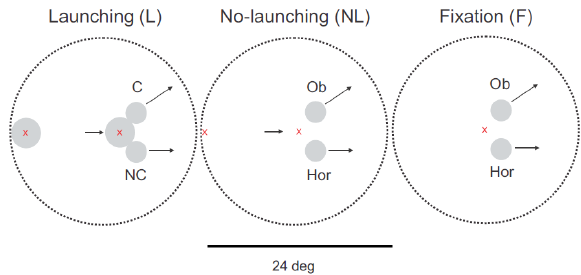
Figure.1 Experimental stimuli. Launching condition: the launcher (‘L’, a round shape of 3 deg size) moved hori- zontally towards the center at a constant velocity of 16 deg/s. The moment L made contact with both targets, its motion stopped and targets started to move (moment of collision/target motion onset; after 1second of visible launcher motion onset). No launching (‘NL’): in this con- dition, only a small fixation cross moved at the same ve- locity than L before targets started to move. Stationary fixation (‘F’): in this condition targets were selected out of stationary fixation located centrally Overall trial length: ~3000ms. C: causal; NC: non-causal; Ob: oblique; H: horizontal. The dashed circle represents the visible aperture on the screen (diameter: 24